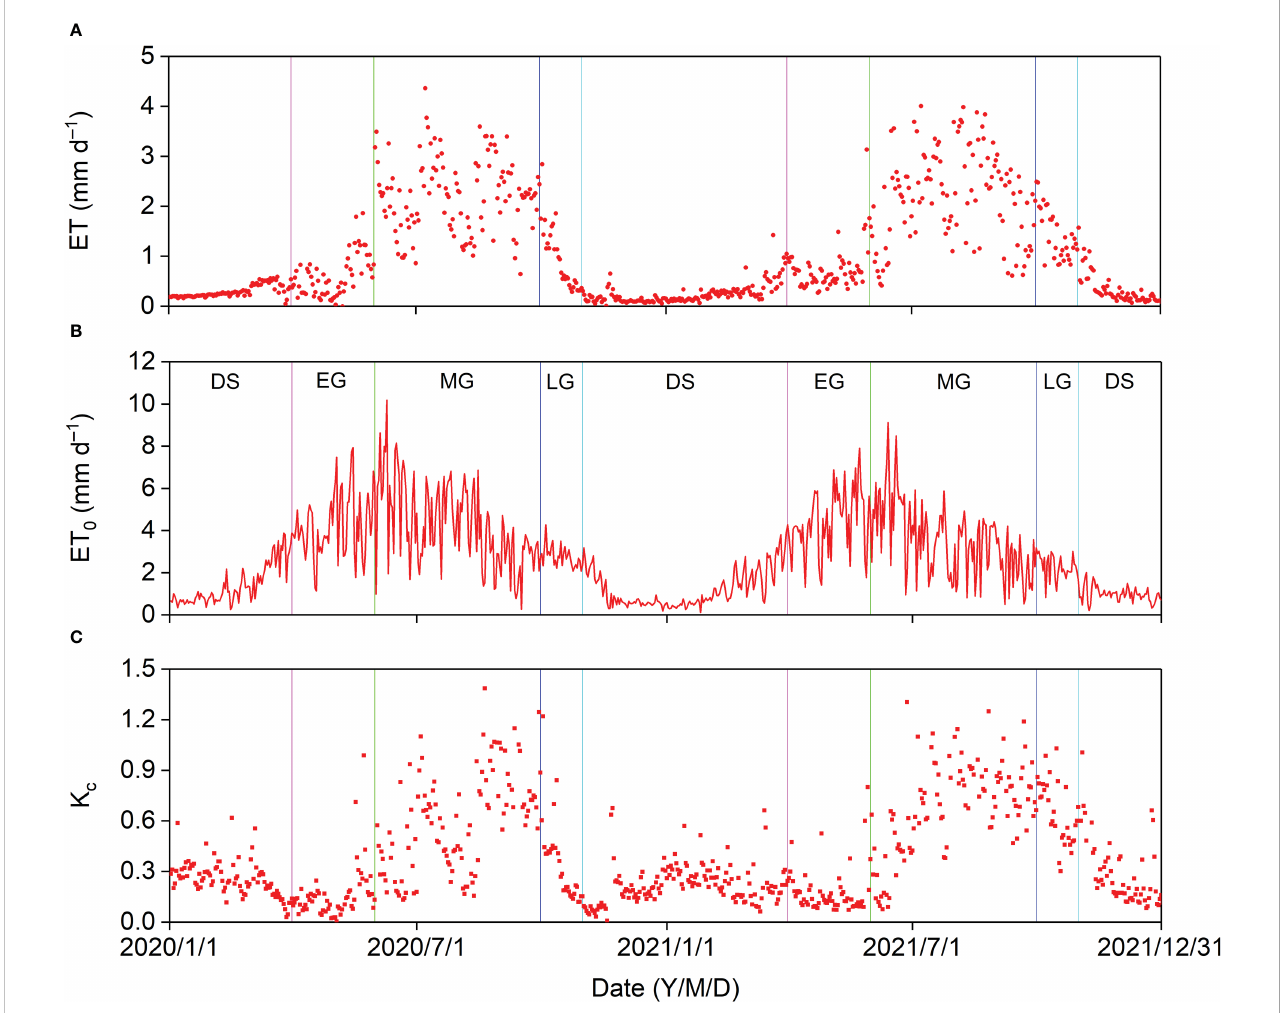
FIGURE 8 Seasonal variation in (A) evapotranspiration (ET), (B) reference evapotranspiration (ET 0 ), and (C) crop coef fi cient (K c ) in 2020 and